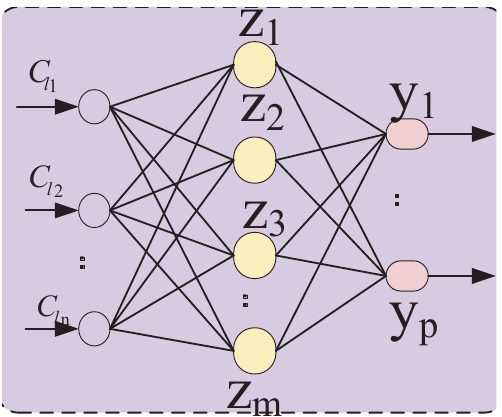
Figure 3. MLP general